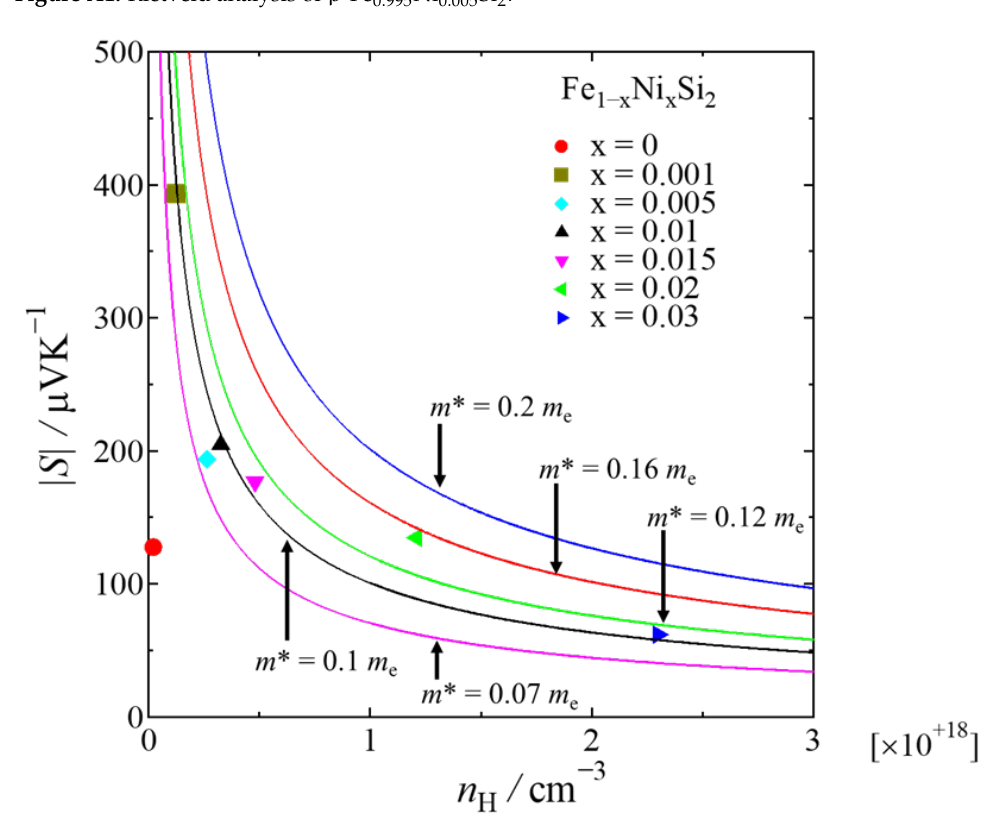
Figure A2. Absolute Seebeck coefficient with respect to carrier concentration at room temperature, where the solid curves represent the calculated data estimated by using Mott’s formula at various effective masses ( m * = x m e , where x is variable and m e is the static mass of electron, i.e., 9.10938 × 10 −3 1 kg).